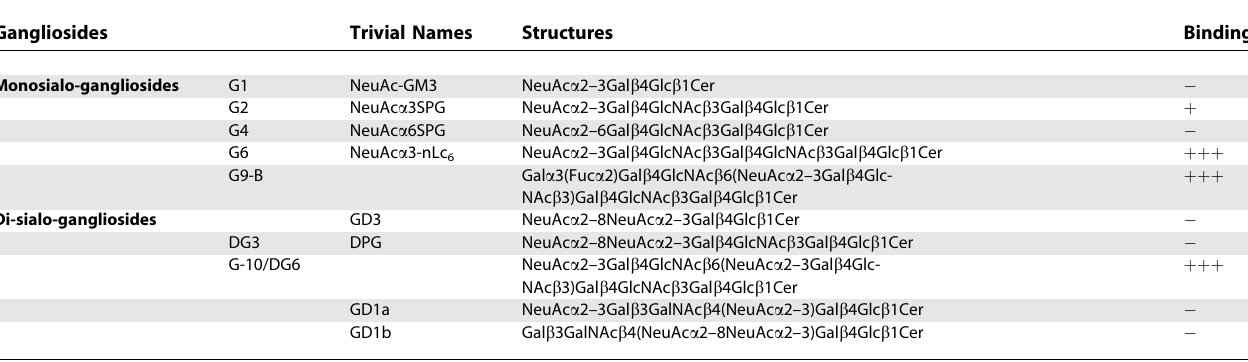
Table 3. Results from Binding of H. pylori to Human Erythrocyte Gangliosides